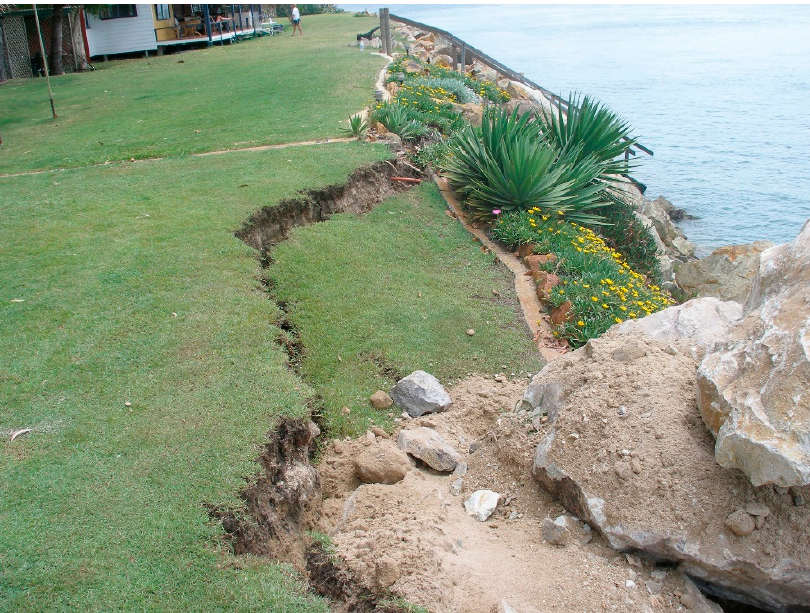
Figure 17. Damage to the ‘Barrier’ at Amity Point (2016) after an RBF event has partly undermined it. Repairs by adding new rock have started. Photo: Beinssen.